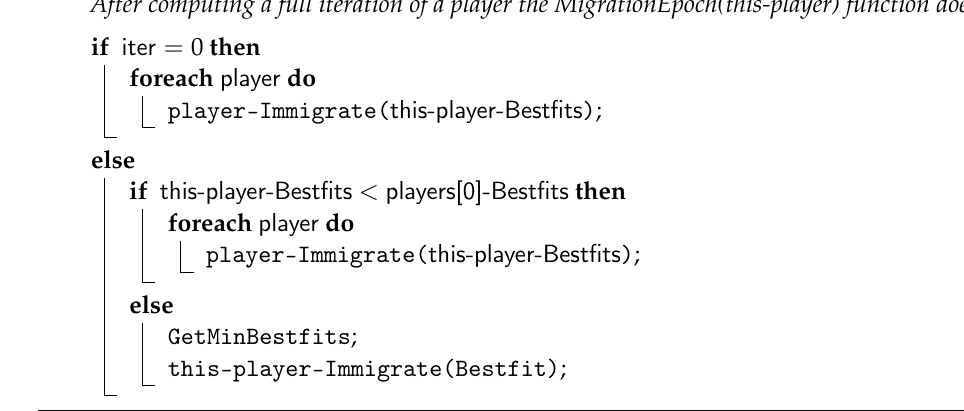
Algorithm 2: Hybrid Method With Gradient